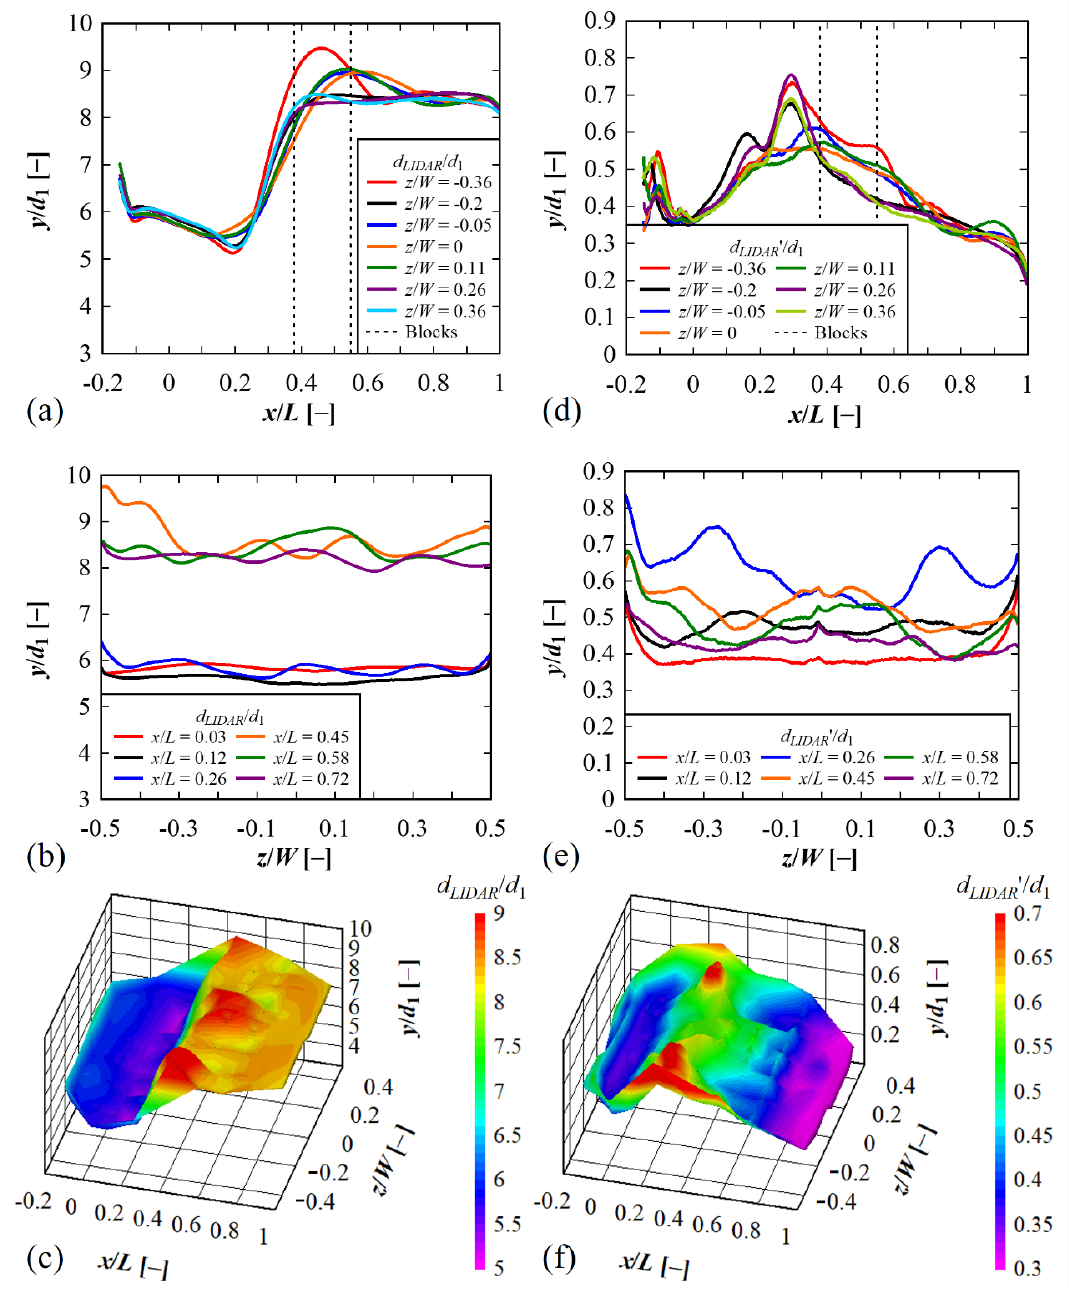
Figure 5. Dimensionless free-surface mean elevations and fluctuations in a stilling basin with super-cavitating blocks for q = 0.19 m 2 /s, Fr 1 = 6.7, and Re = 1.9 × 10 5 : ( a – c ) mean elevations ( d LIDAR / d 1 ): ( a ) longitudinal; ( b ) transverse; ( c ) three-dimensional mapping of mean elevations; ( d – f ) fluctuations ( d LIDAR ’/ d 1 ): ( d ) longitudinal; ( e ) transverse; ( f ) three-dimensional mapping of free-surface fluctuations.